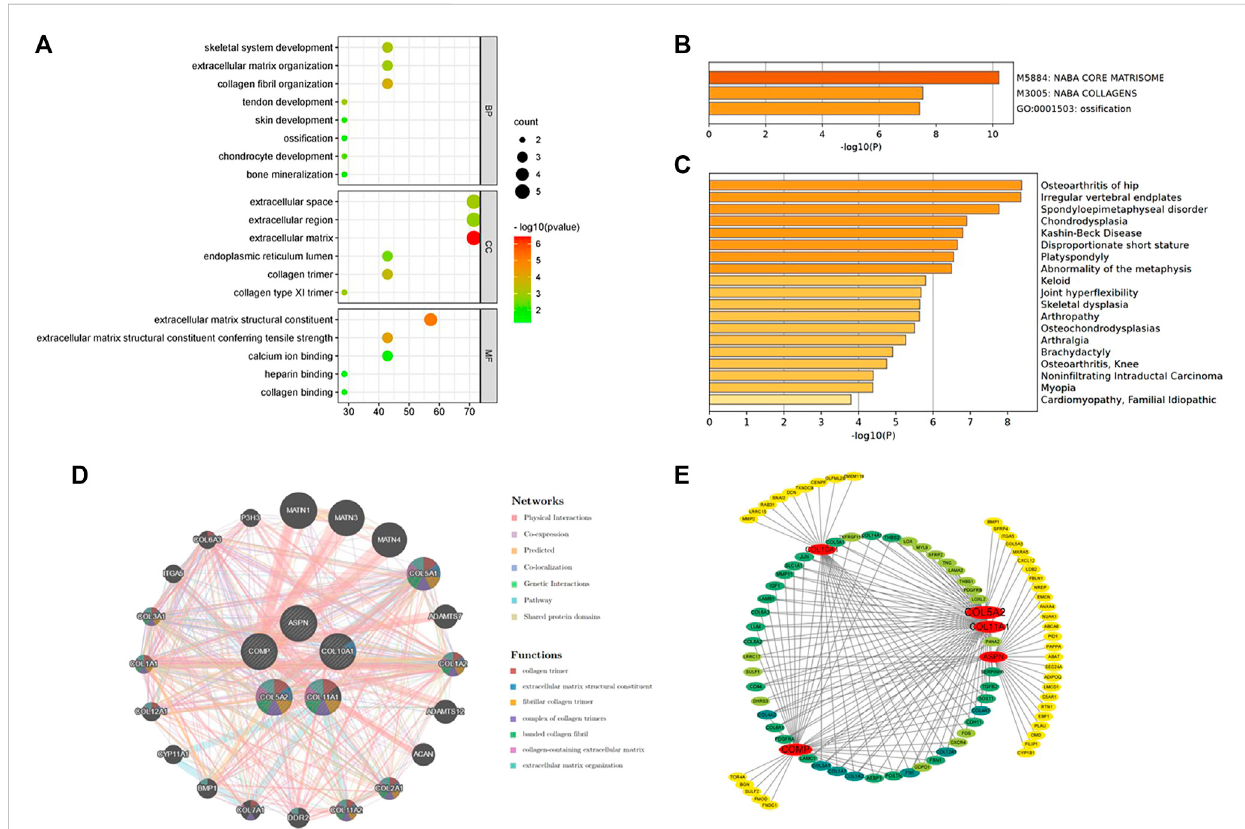
FIGURE 4 (A) Biological processes enriched by the fi ve hub genes. (B) Pathway and process enrichment analysis on the Metascape platform. (C) Enrichment analysis in DisGeNET. (D) Interaction network of the hub genes and their predicted genes via GeneMANIA. (E) Functional annotation of hub genes using